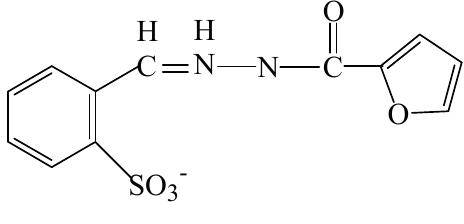
Figure 1. The structure of